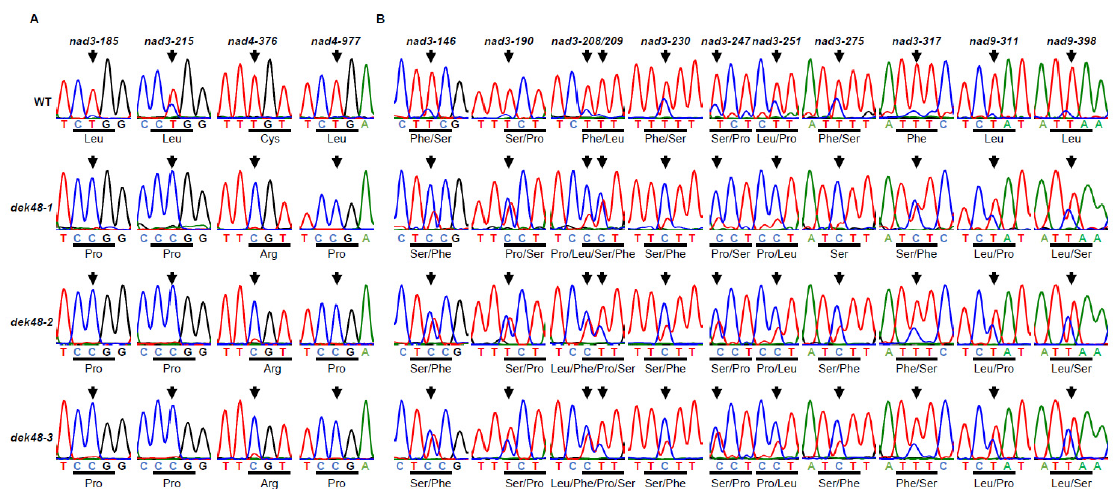
Figure 6. RNA editing defects of mitochondrial genes in dek48 alleles. ( A ) Loss of DEK48 function abolishes the editing at nad3 -185, -215 and nad4 -376, -977 sites. Analysis of RNA editing at nad3 -185, -215 and nad4 -376, -977 sites in the transcripts from embryo and endosperm of WT and dek48 mutants at 12 DAP. ( B ) Decreased RNA editing in dek48 alleles relative to WT at eleven other sites. Editing sites are indicated by arrows. Codons containing the edited nucleotide are underlined, and the coded amino acids are shown.